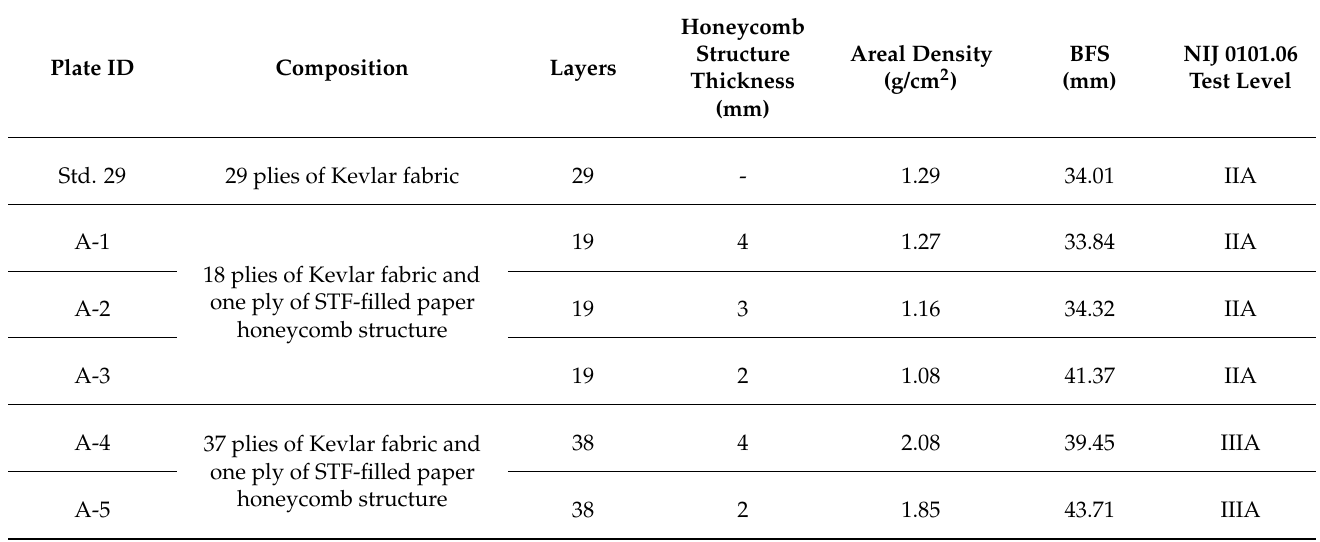
Table 1. Results for ballistic test of Kevlar/STF-filled paper honeycomb